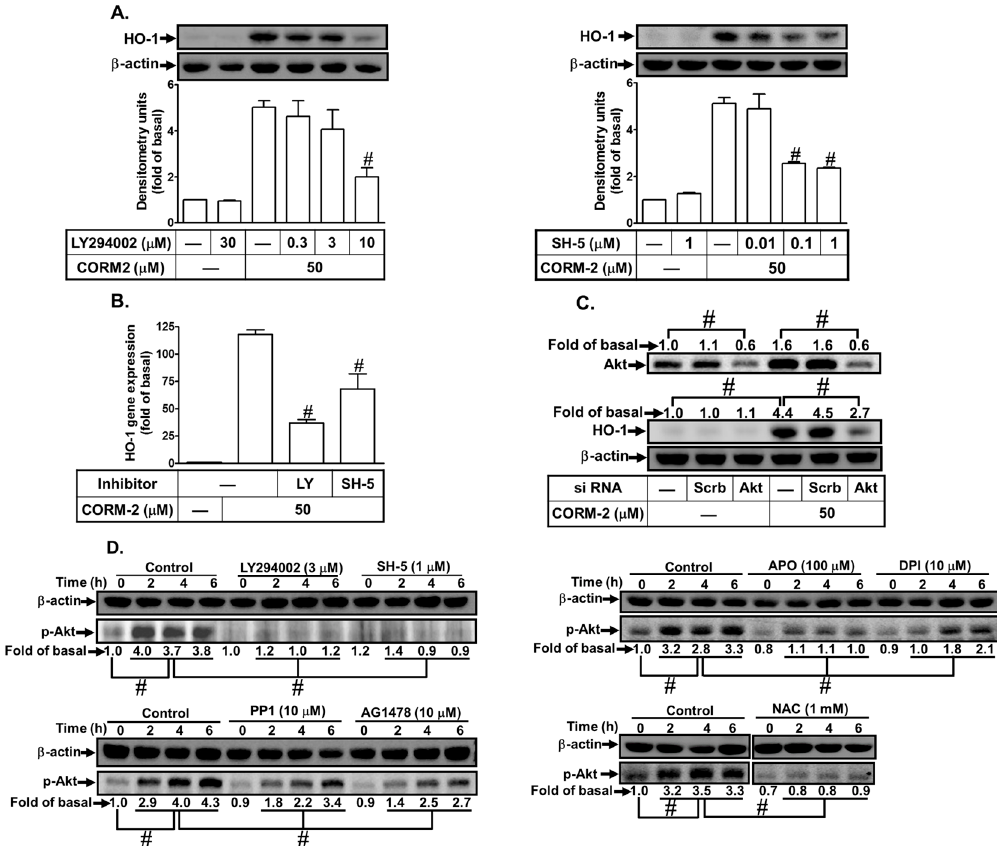
Figure 6. CORM-2 induces HO-1 expression via PI3K/Akt. ( A ) HPAEpiCs were pretreated with LY294002 or SH-5 for 1 h and then incubated with CORM-2 for 16 h. The protein levels of HO-1 and β -actin were determined by western blot. ( B ) Cells were pretreated with LY294002 (10 µ M) or SH-5 (1 µ M) for 1 h and then incubated with CORM-2 for 6 h. The mRNA expression of HO-1 was determined by real-time PCR. ( C ) Cells were transfected with scrambled or Akt siRNA and then incubated with CORM-2 for 16 h. The levels of Akt, HO-1, and β -actin protein were determined by western blot. ( D ) Cells were pretreated without or with LY294002, SH-5, PP1, AG1478, APO, DPI, or NAC for 1 h and then incubated with CORM-2 for the indicated time intervals. The protein levels of phospho-Akt and β -actin were determined. Data are expressed as mean ± S.E.M. of three independent experiments ( n = 3). # p < 0.01, as compared with the cells exposed to CORM-2 alone or compared between the indicated groups.